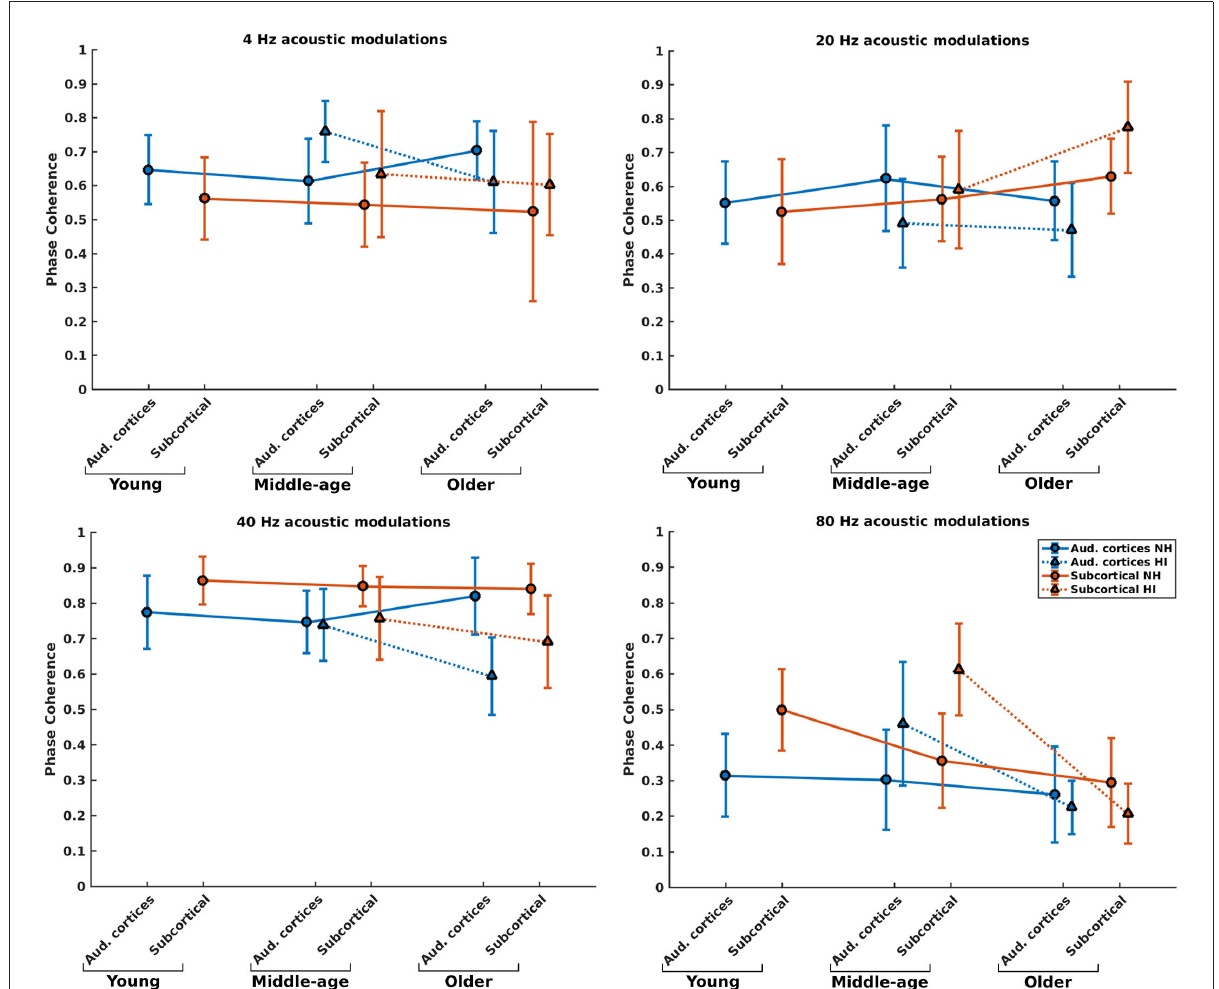
FIGURE4 Phase coherence of the neural generators in auditory cortices and subcortical area in NH and HI participants regardless of the side of stimulation across age and modulation frequency. The circle and triangle symbols indicate the pooled means, and error bars represent the pooled standard deviations